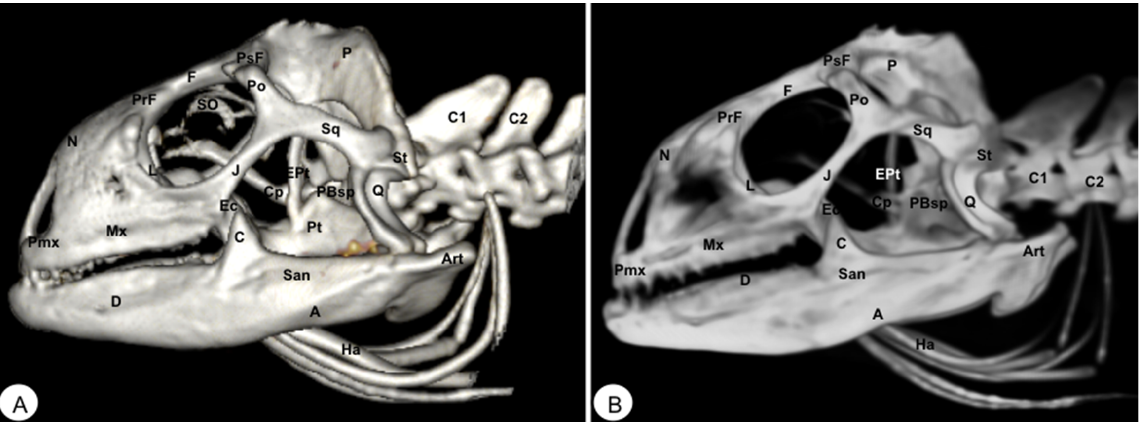
Figure 8. Head of Iguana iguana . ( A ) Lateral VR image. ( B ) Lateral MIP image. Pmx: Premaxillary. Mx: